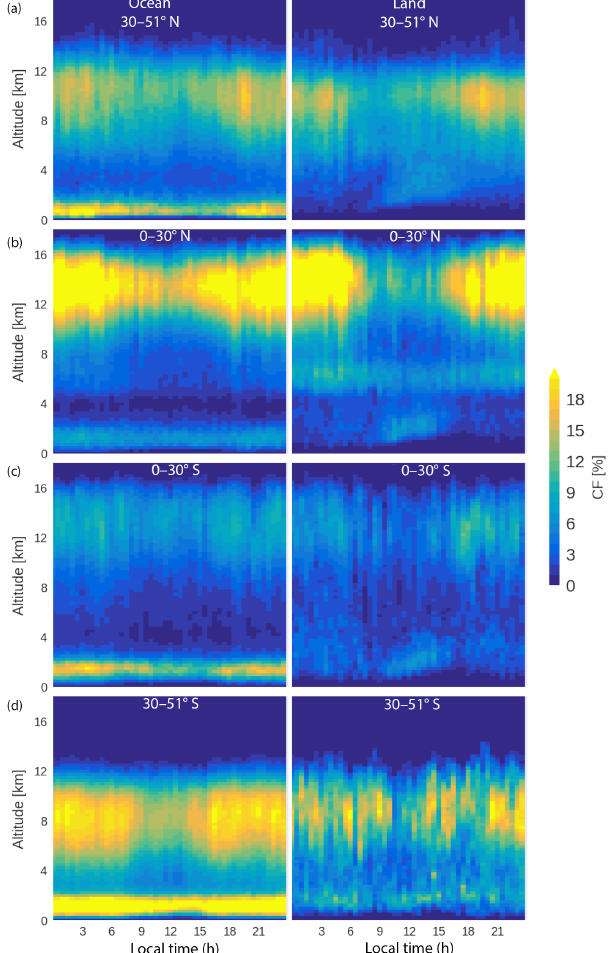
Figure 2. As in Fig. 1, over the Northern Hemisphere midlati- tudes (row a ) and tropics (row b ) and over the Southern Hemisphere tropics (row c ) and midlatitudes (row d ) during JJA from 2015 to